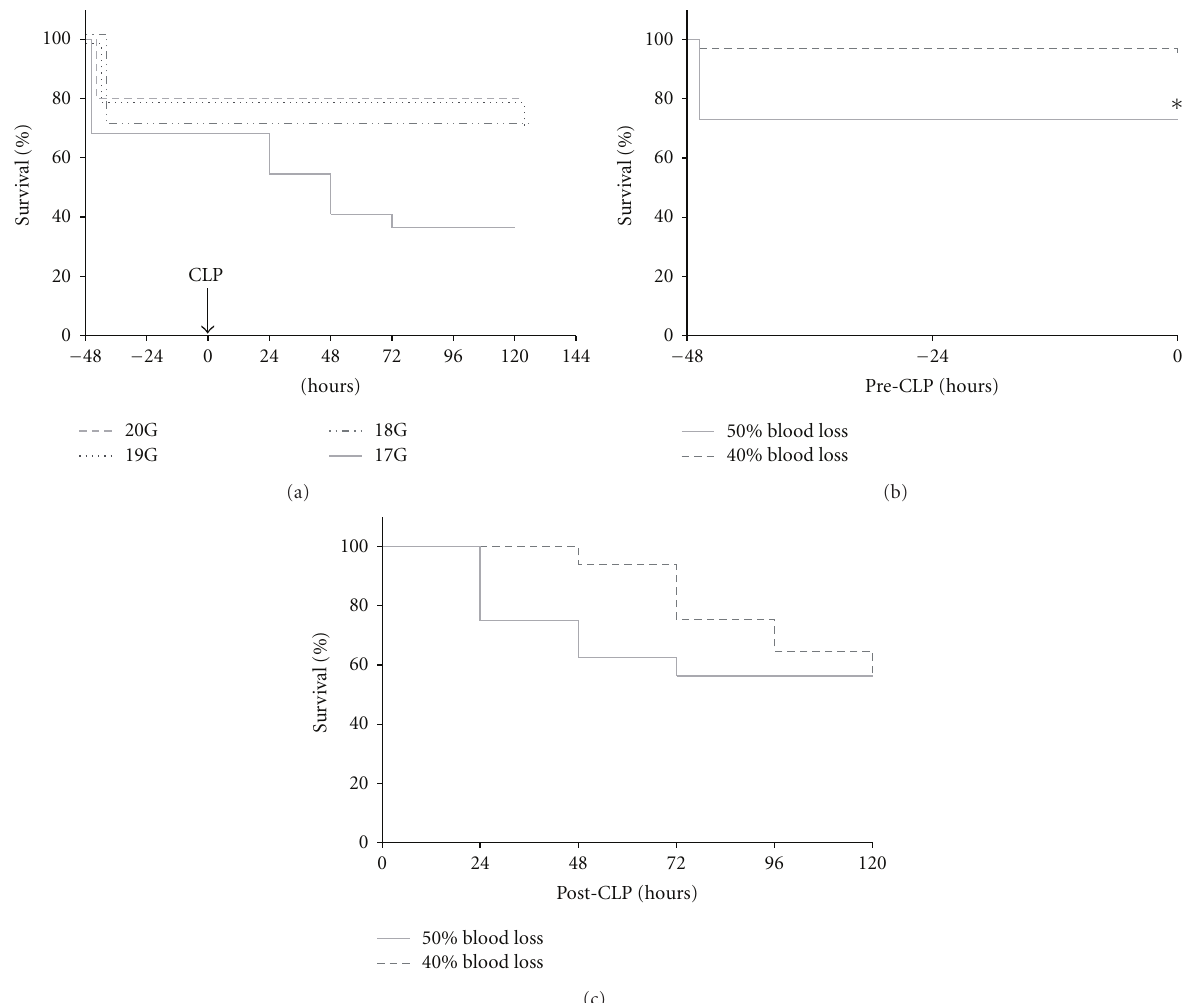
Figure 2: 7-day mortality in 3-month-old female mice subjected to the two-hit model of trauma/hemorrhage followed by polymicrobial CLP-induced sepsis. To achieve approximately 50% mortality at post-TH day 7 (50% hemorrhage of total blood volume, TBV), the severity of CLP was adjusted by di ff erent gauge needles (20G n = 10, 19G n = 10, 18G n = 10, 17G n = 22). To reach sublethality after hemorrhage, ∗ P < . 05 between 50 and 40% blood loss group (of TBV) was tested with a 17-gauge needle (40% + 17G n = 65; 50% + 17G n =